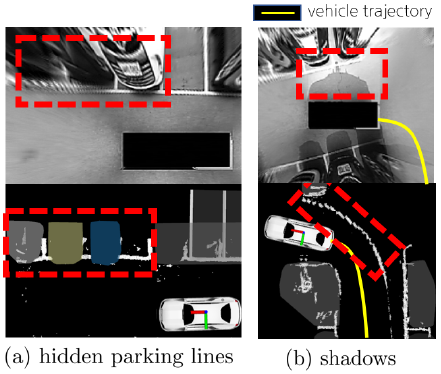
Figure 15. The main reasons for parking space detection performance degradation. ( a ) The case where the parking line is obstructed by vehicles. ( b ) The case where shadows are accumulated along the trajectory of the